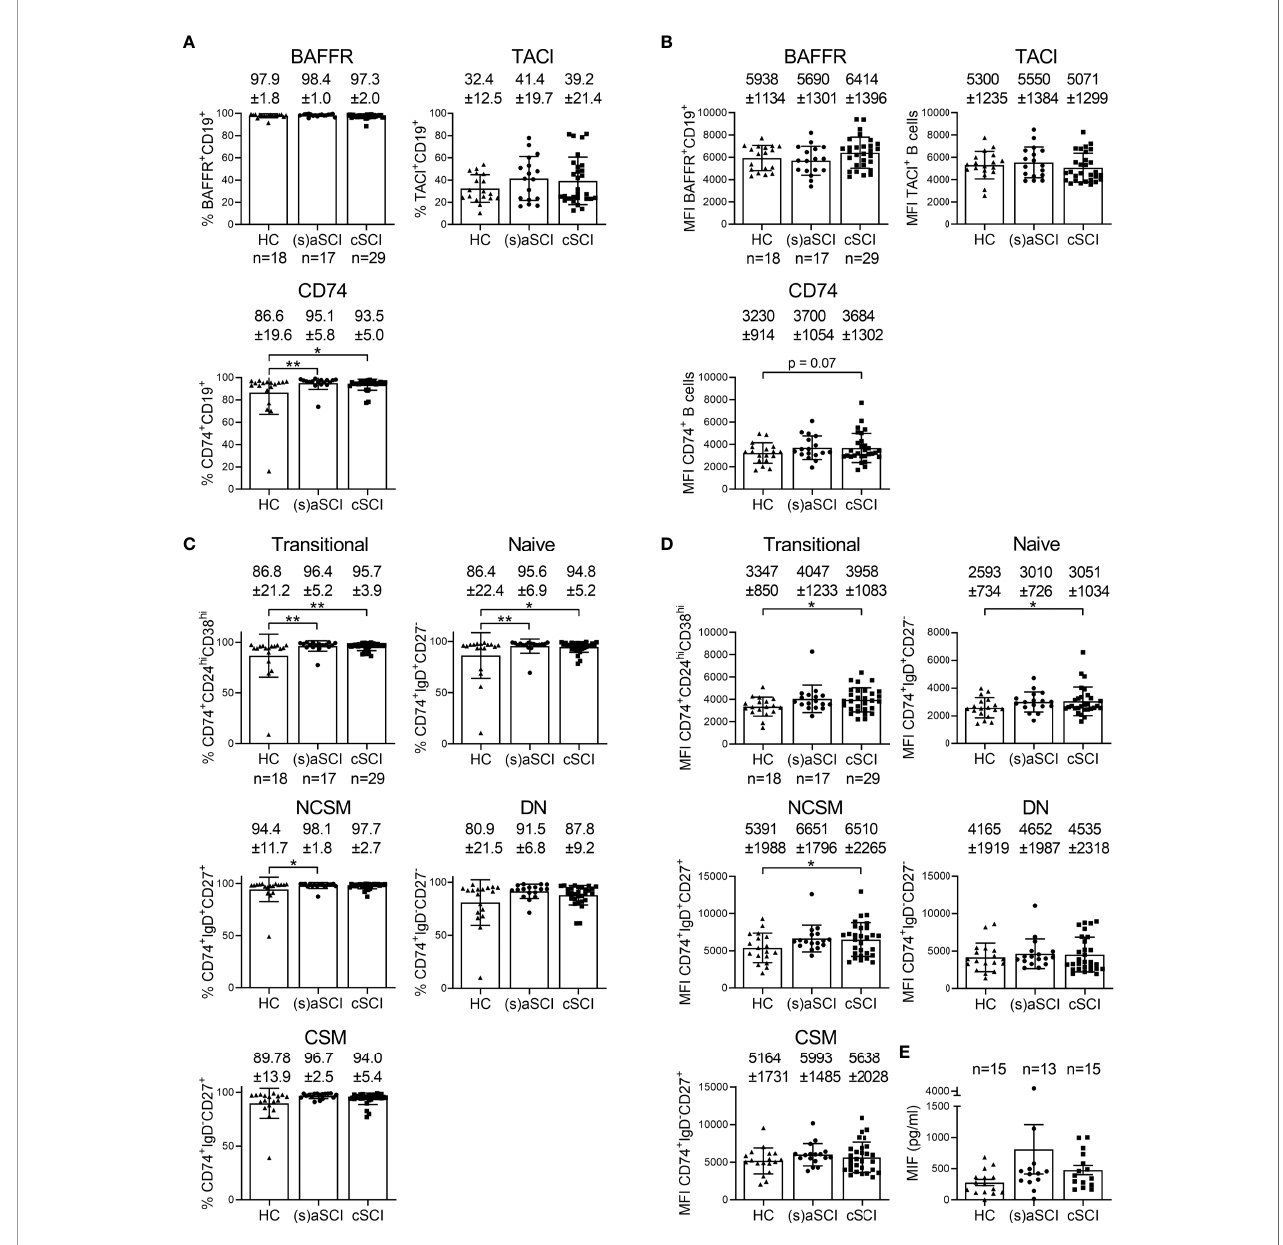
FIGURE 6 | Involvement of B cell survival receptor expression in post-SCI immunity. Percentages (A) and median fl uorescence intensity (MFI) (B) of B cells expressing BAFFR, TACI and CD74 are shown within the B cell population of HC (n = 18) and SCI patients (n = 18), including (s)aSCI (17 samples) and cSCI (29 samples). Mean (bars) ± SD is depicted and shown in numbers. Percentages (C) and MFI (D) of CD74 expression is shown for transitional, naive, NCSM, DN and CSM B cell subsets of HC (n = 18) and SCI patients (n = 18), including (s)aSCI (17 samples) and cSCI (29 samples). (E) The concentration of MIF (pg/ml) in the plasma is shown for HC (n = 15) and SCI patients (n = 18), including (s)aSCI (n = 13 samples) and cSCI (n = 15 samples). Mean (bars) ± SD is depicted. Numbers of included samples in each group are also indicated in the fi rst graph of each fi gure panel. *p < 0.05, **p <